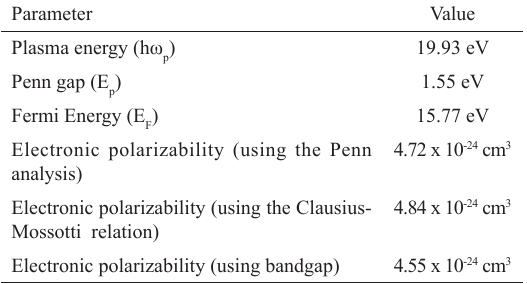
Table 1: Electronic parameters of the CoS thin films Parameter